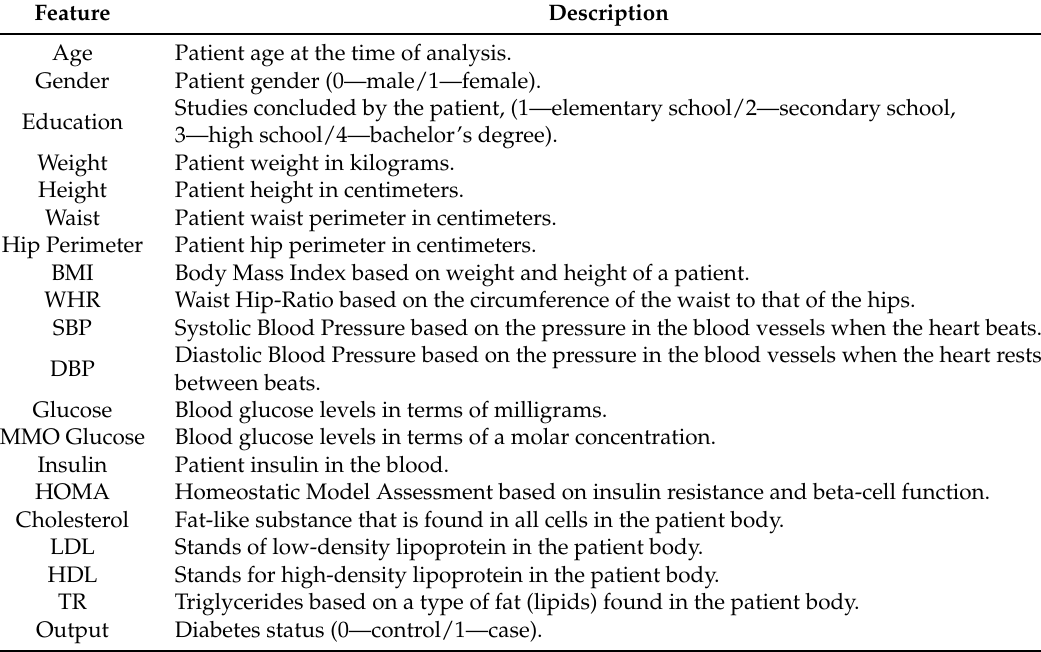
Table 1. Features